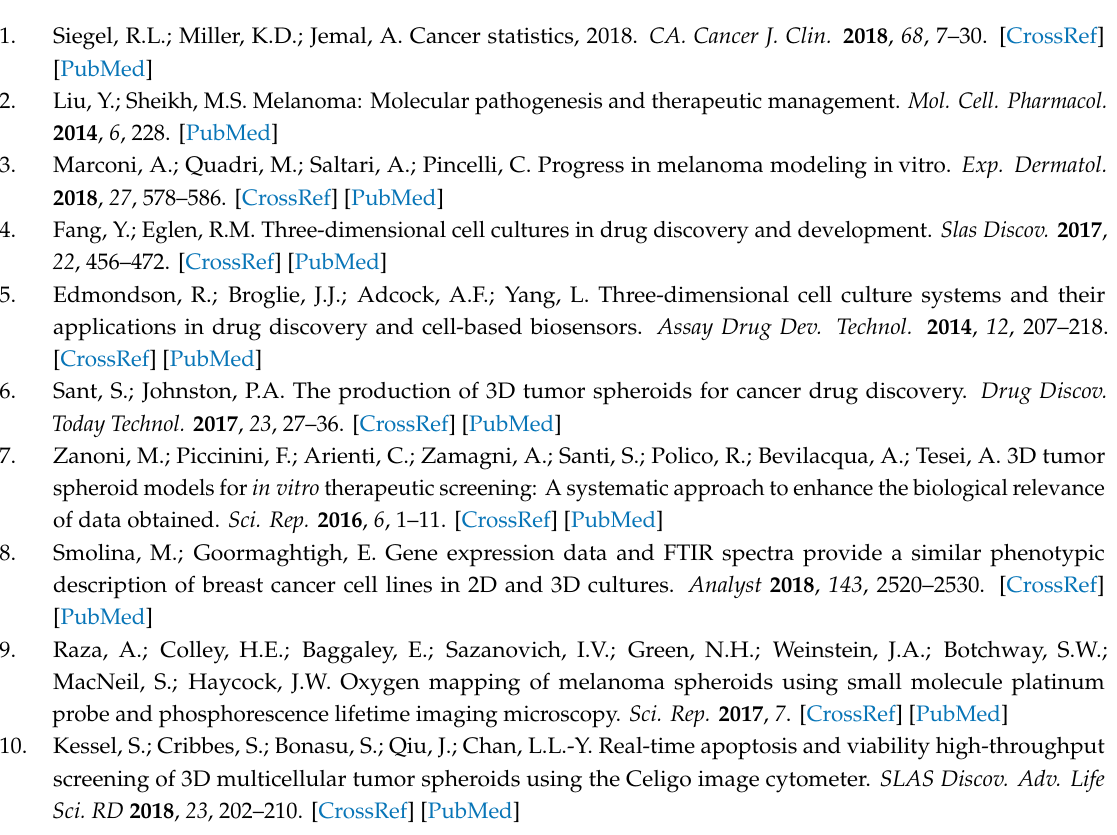
Table S1: Pearson correlation coe ffi cient between biocomponent of spheroid cells and mode of cell death and spheroid